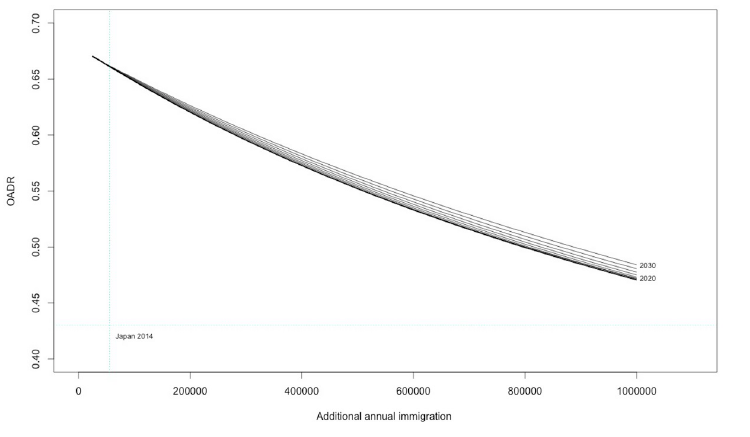
Fig 3. Migration model